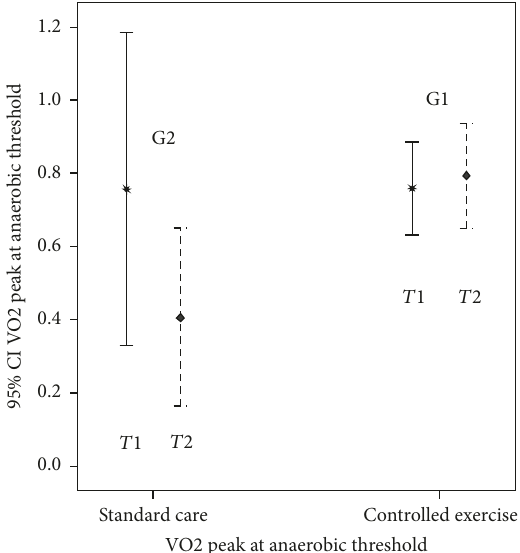
Figure 5: VO2 at the Anaerobic Threshold, T 1 ( 𝑝 = 0.8 , [CI 95%: − 0,23–0,29]) and T 2 ( 𝑝 = 0.02 , [CI 95%: − 0,70– −